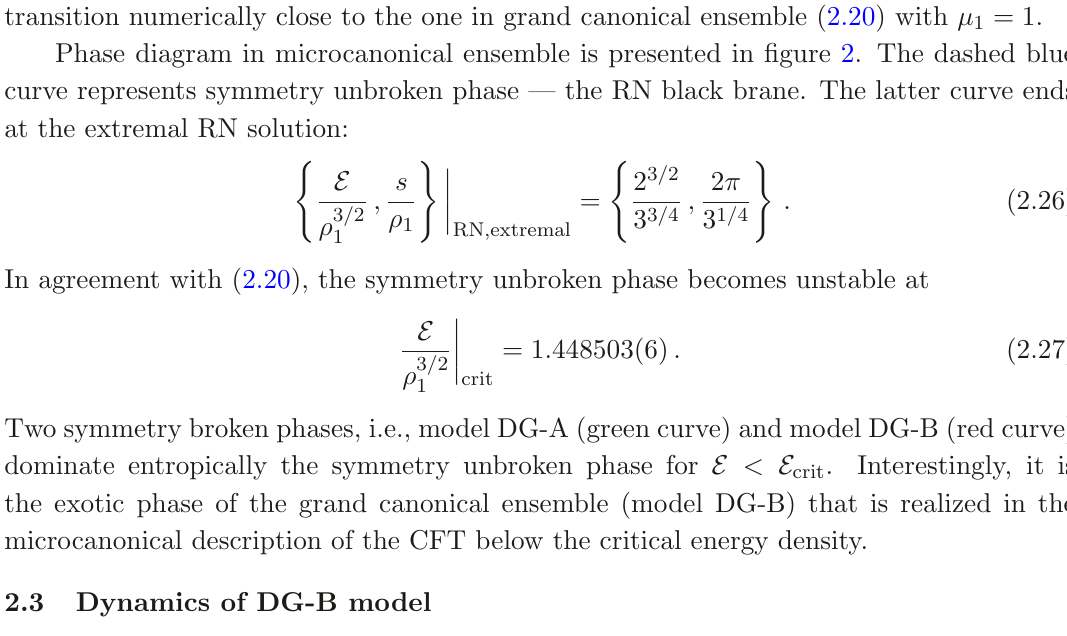
Figure 2 . Entropy density s as a function of the energy density DG-B (red curve) and the RN black brane (dashed blue